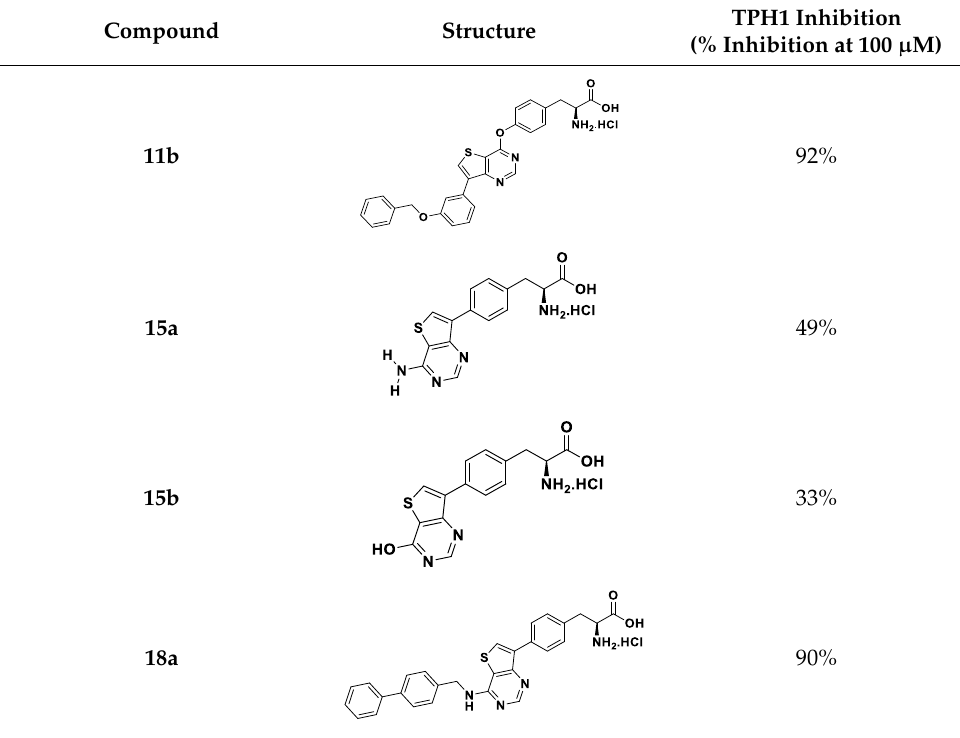
Table 1. Cont. Compound